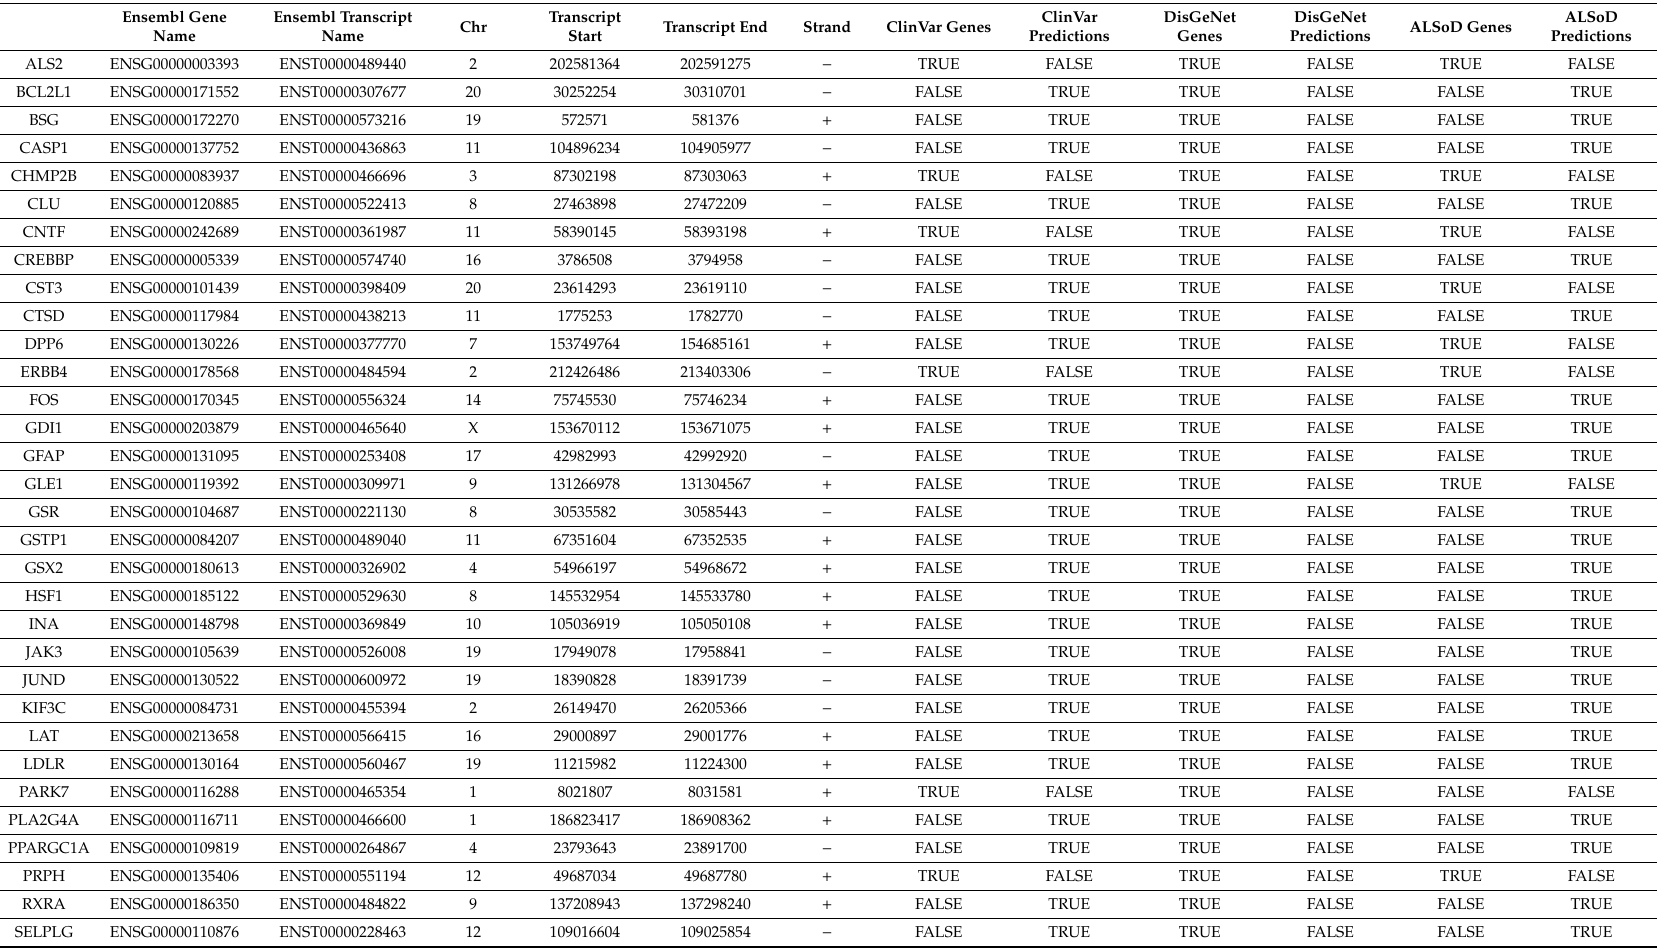
Table 2. Genes predicted to be linked to ALS by the model trained on the manually curated list. For each gene, we reported the Ensembl gene name, coordinates (hg19) of the longest transcript, strand, and whether the gene was present in the other lists of genes or among their model predictions. Please note that if a gene were present in one list, it could not be predicted by its corresponding